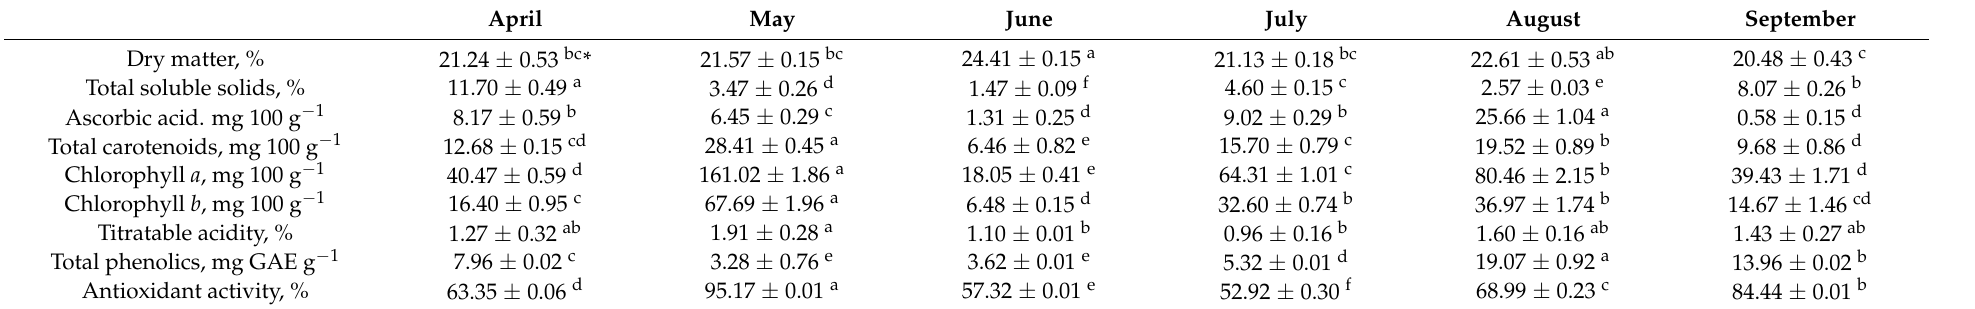
Table 1. Chemical composition of stinging nettle ( Urtica dioica L.) leaves